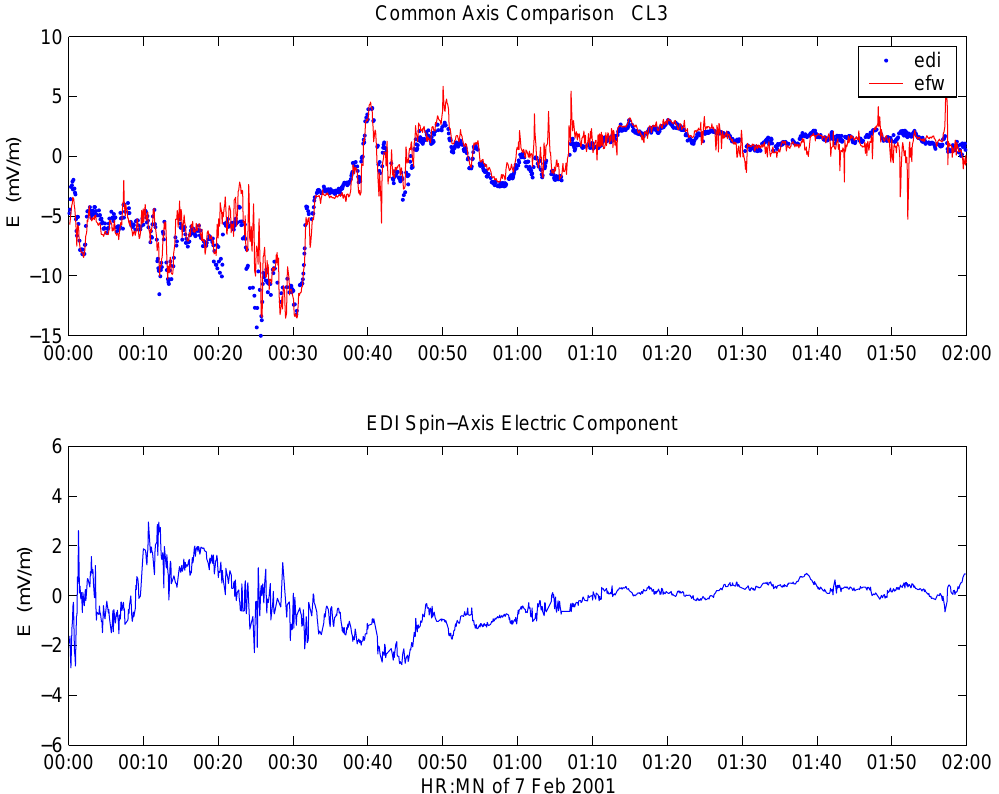
Fig. 15. Comparison of EDI and EFW electric fields. The top panel shows the component of E along the common axis defined in the text. The bottom panel shows the spin axis component measured by